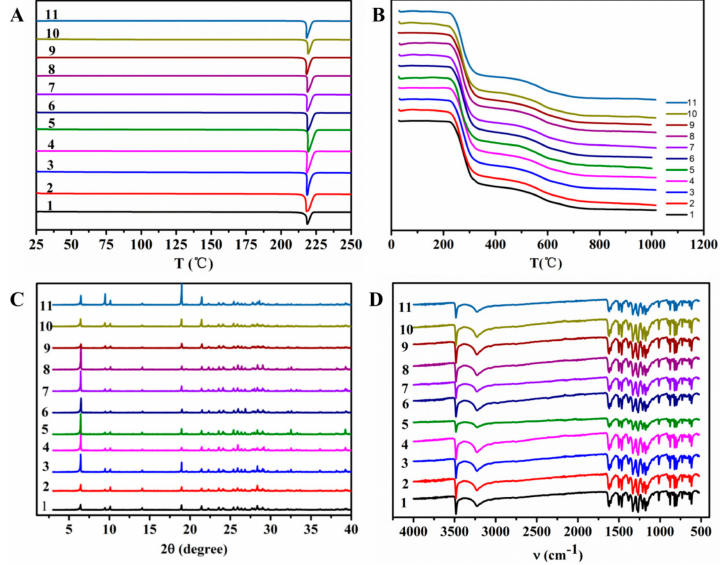
Figure 5. The characterization information of crystal forms of LM49-API . ( A ) Di ff erential scanning calorimetry (DSC) analysis. ( B ) Thermogravimetry (TG) analysis. ( C ) X-ray powder di ff raction (XRD) spectrum. ( D ) Infrared (IR)